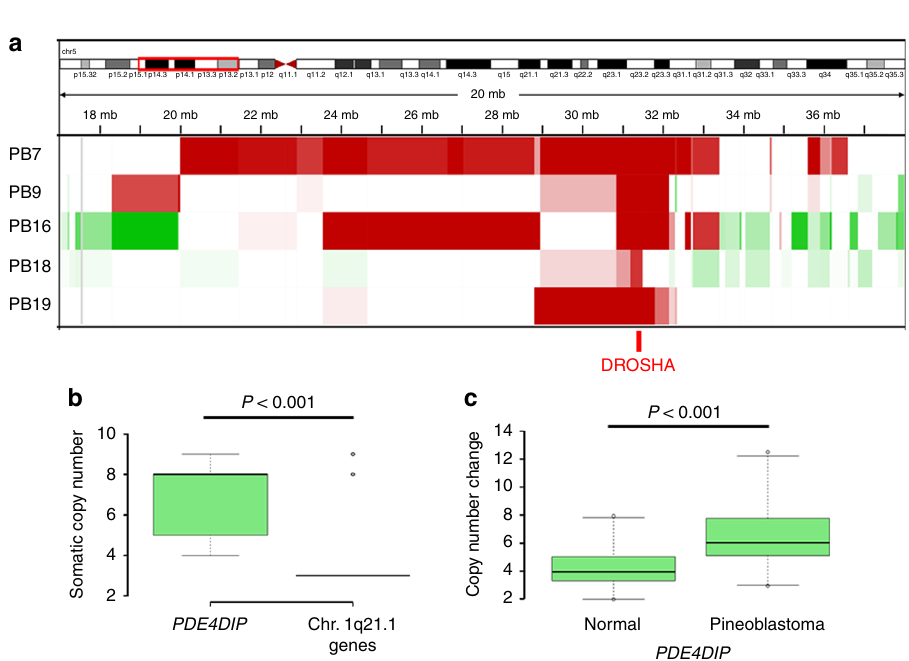
Fig. 3 Focal copy-number aberrations in pineoblastoma. a Homozygous deletions of DROSHA were identi fi ed in fi ve pediatric pineoblastomas. For four out of fi ve cases with DROSHA deletion, the deletion is about 1.300 – 3.755kb including the whole DROSHA gene. For one case, the deletion seems to be only